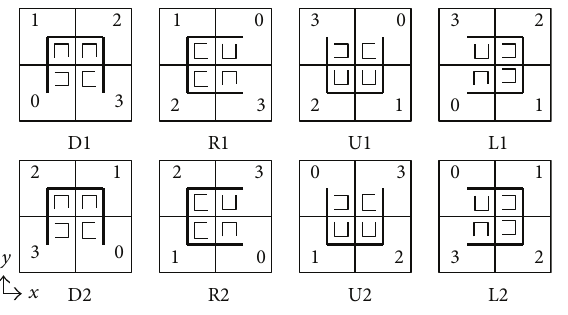
Figure 4: Fractal rules of Hilbert